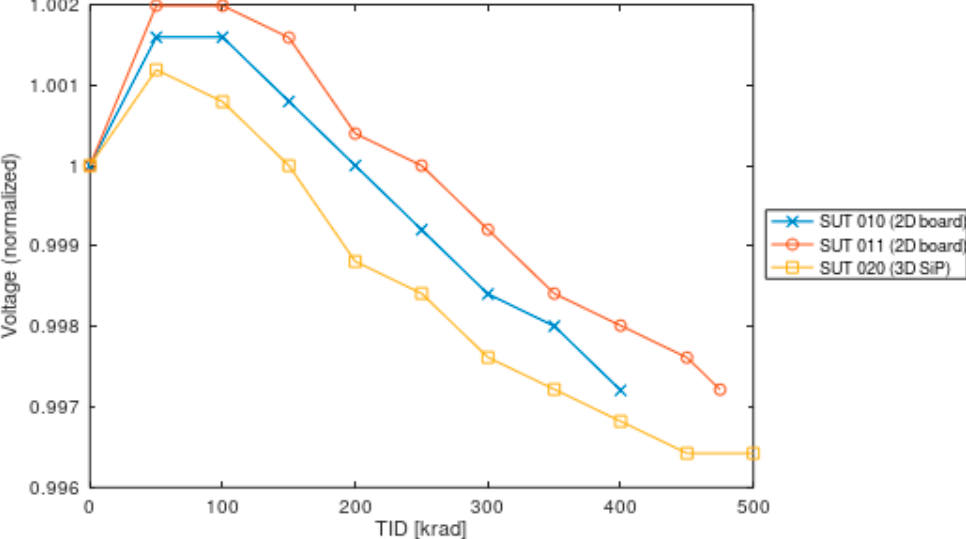
Figure 3. Output voltage (normalized) of SUTs as a function of the total ionizing dose (X-ray irradiation). SUT 010 and SUT 011 failed, respectively, at 450 and 500 krad (measurements performed at these two TID steps have shown that output voltage is ~0 V and that most of the internal subsystems are not working). The 3D SiP was still fully functional.